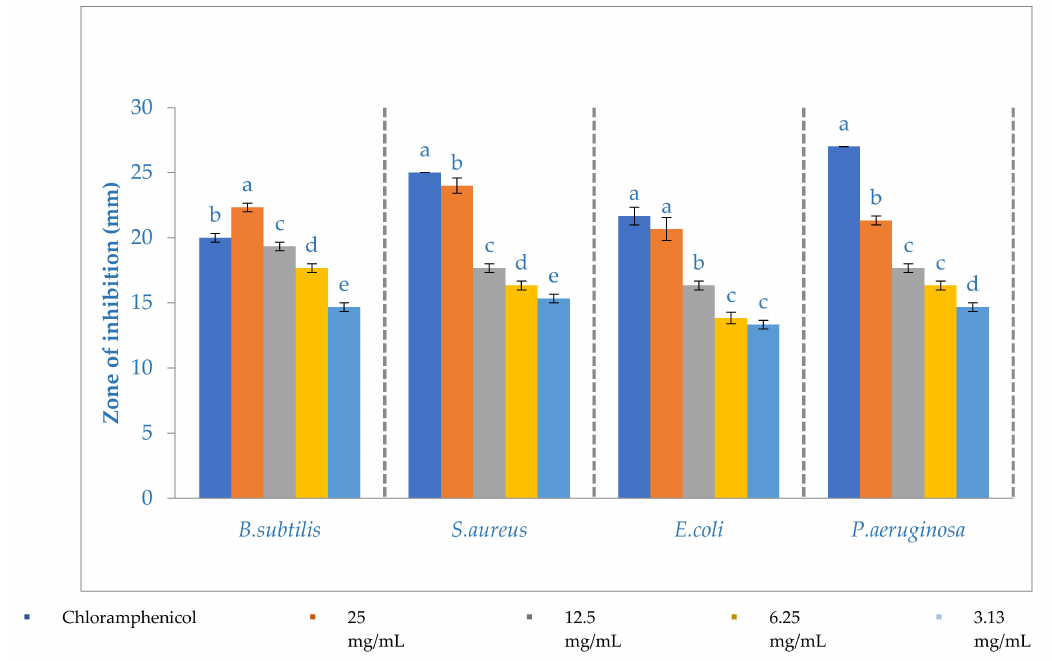
Figure 8. Antibacterial activity of nanoparticles (N1C1) synthesized from isolated microbial strain from soil of Gilgit at altitude of 3670 m (from rhizosphere of Potentilla atrosanguinea, Family; Rosaceae ) against pathogenic strains Bacillus subtilis , Staphylococcus aureus , Escherichia coli , and Pseudomonas aeruginosa at different concentrations. Different letters are indicating significant differences ( p < 0.05) among